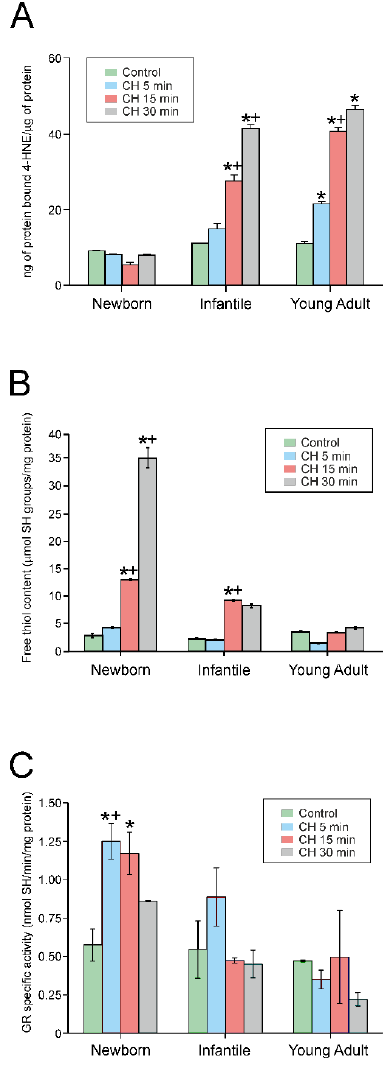
Figure 4. Antioxidant capacity of motor cortex neurons during development in response to cumene hydroperoxide (CH). ( A ) Lipid peroxidation expressed in ng of protein-bound 4-hydroxynonenal (4-HNE)/µg of protein. A bar chart representing the concentration of 4-NHE in the control condition and after 5, 15, and 30 min of 10 µM CH exposure in each experimental group (newborn, n = 6; infantile, n = 6; and young adult, n = 6) at 0 (green), 5 (blue), 15 (red), and 30 min (grey) after the exposure of CH. Note the increase in lipid peroxidation 15 min after the exposure to CH in infantile rats, and after 5 min in young adult rats. ( B ) Free thiol content in brain slices treated with CH . A bar chart representing the concentration of free thiols in the control condition and after 5, 15, and 30 min of CH exposure in each experimental group (newborn, infantile, and young adult). Note that neurons from newborn rats are more efficient at producing free thiols in response to CH than neurons from infantile and young adult rats. ( C ) Activation of glutathione reductase (GR) in response to the oxidative stress induced by CH . A bar chart representing the activity of glutathione reductase (nmol Sh/min/mg protein) in the control condition and after 5, 15, and 30 min of CH exposure in each experimental group. Note the increase in activity 5 min after the exposure to CH in newborn rats. In A – C, * indicates a significant difference from the control condition, + indicates a difference between adjacent columns, and a represents a statistically significant difference between an age group and the precedent one (infantile vs. newborn and young adult vs. infantile) for the same period of time. The significance level was established as p ≤ 0.05. All data are presented as the mean ± standard error of the